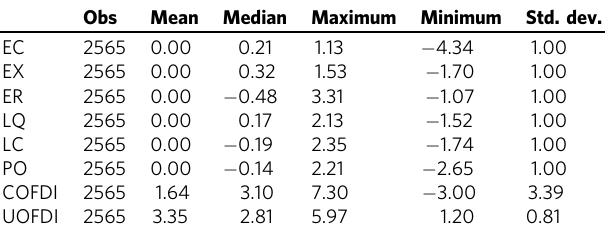
Table 2 Descriptive statistics of the variables. Obs Mean Median Maximum Minimum Std.